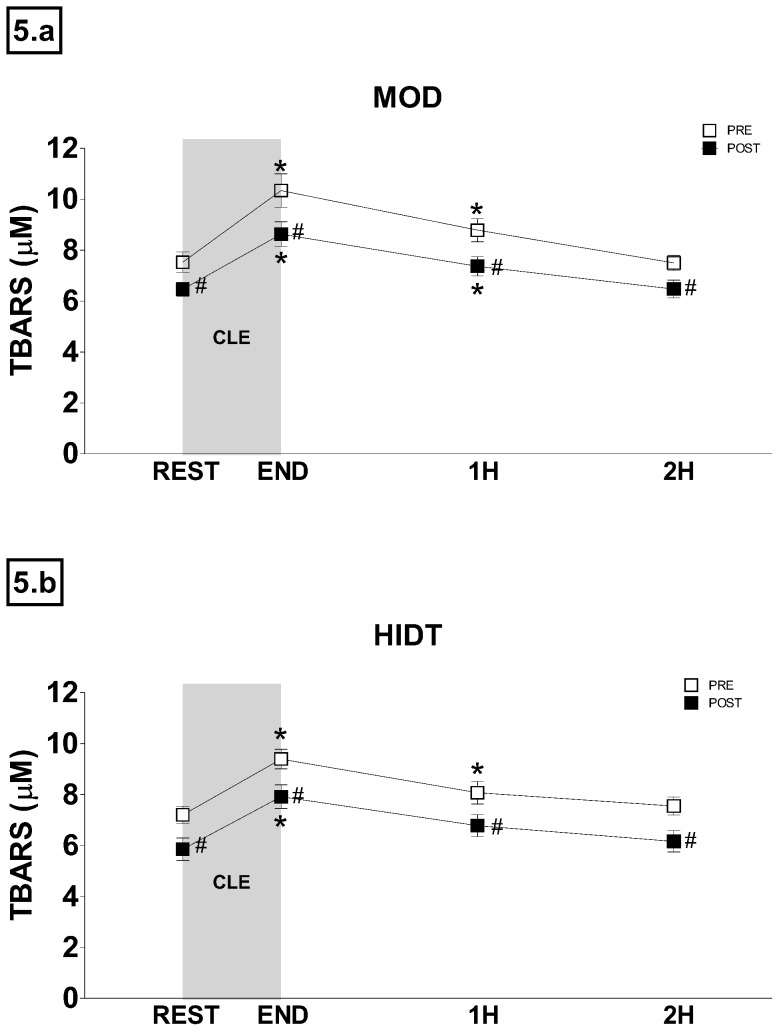
Time course changes of TBARS concentration recorded before (REST) and after (END, 1H and 2H) constant-load submaximal exercise trials (CLE).White squares indicate pre training (PRE) values and black squares post-training (POST) values. Values are expressed as means ± SD. *P<0.05 compared to REST. #P<0.05 compared to PRE.